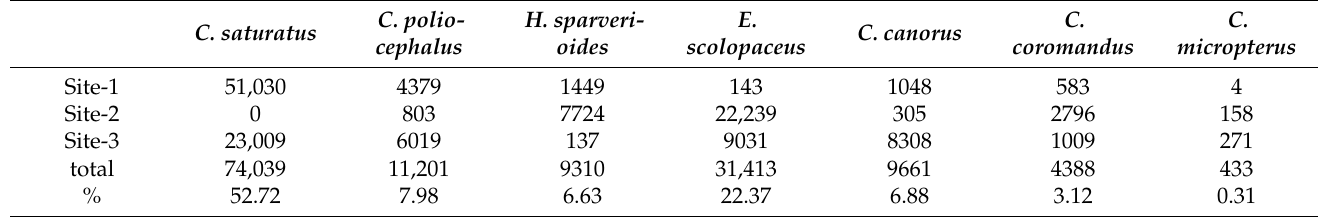
Table 1. Number of calls identified for each species at three sites in Yaoluoping National Nature Reserve